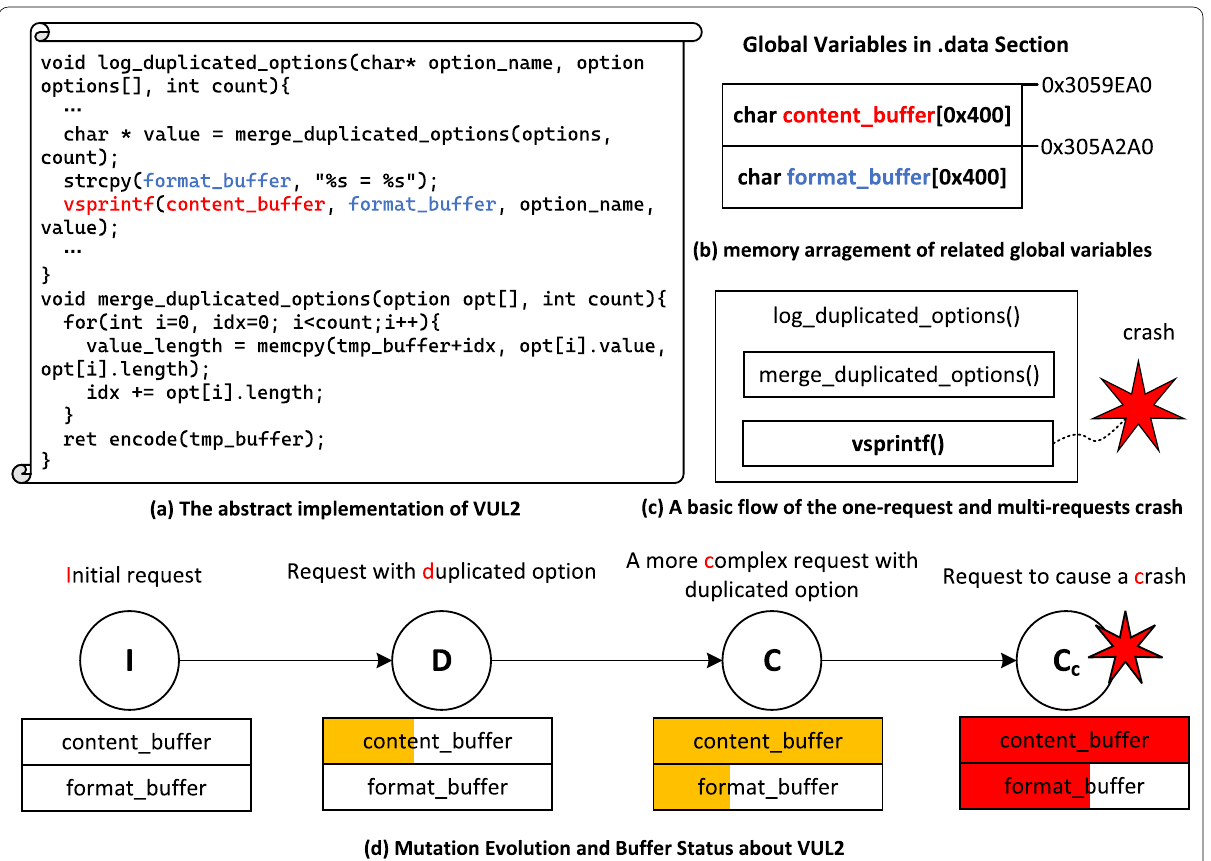
Fig. 8 Detailed information about VUL2